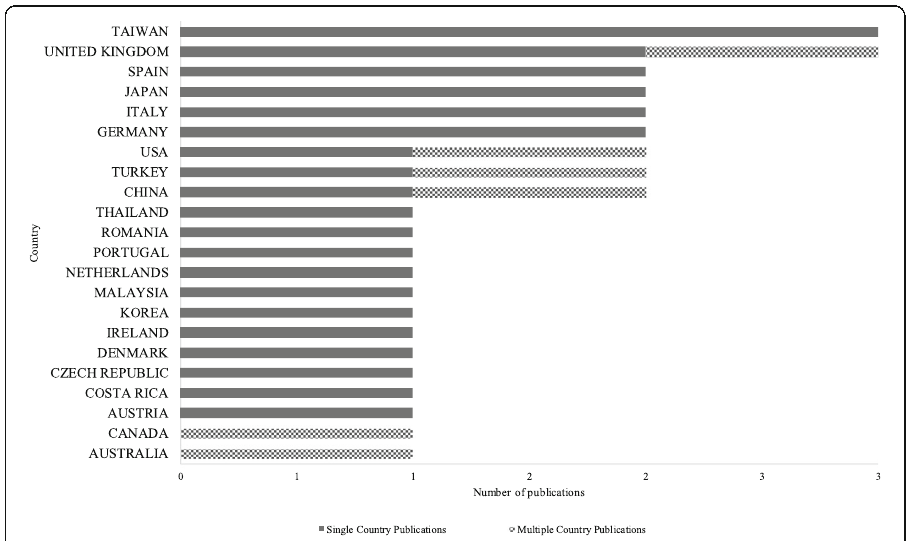
Fig. 5 Most productive countries of the textual